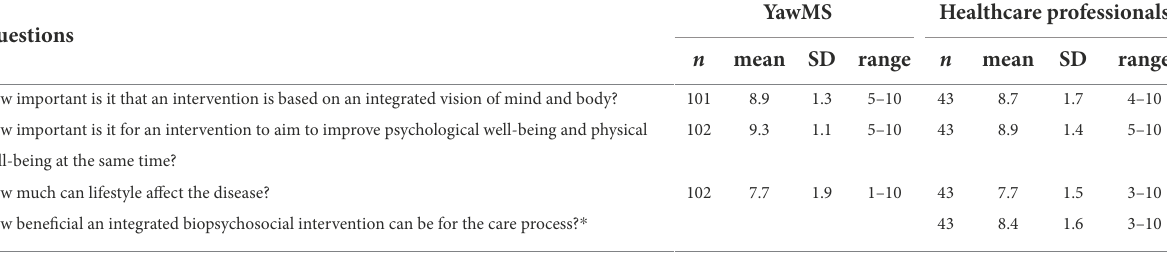
TABLE 1 Survey with young adults with MS and with healthcare professionals: opinions regarding relevance and usefulness of a bio-psycho-social intervention.